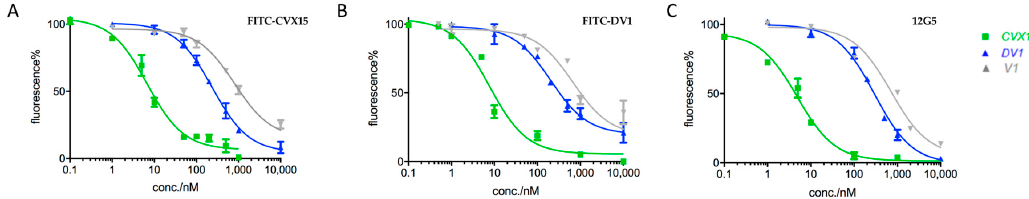
Figure 3. Competitive binding affinities of CXCR4 ligands Type 1 including CVX15, DV1 and V1 respectively in ( A ) FITC-CVX15, ( B ) FITC-DV1, and ( C ) 12G5-based binding assays. Mean ± standard deviation; n = 3 independent experiments.